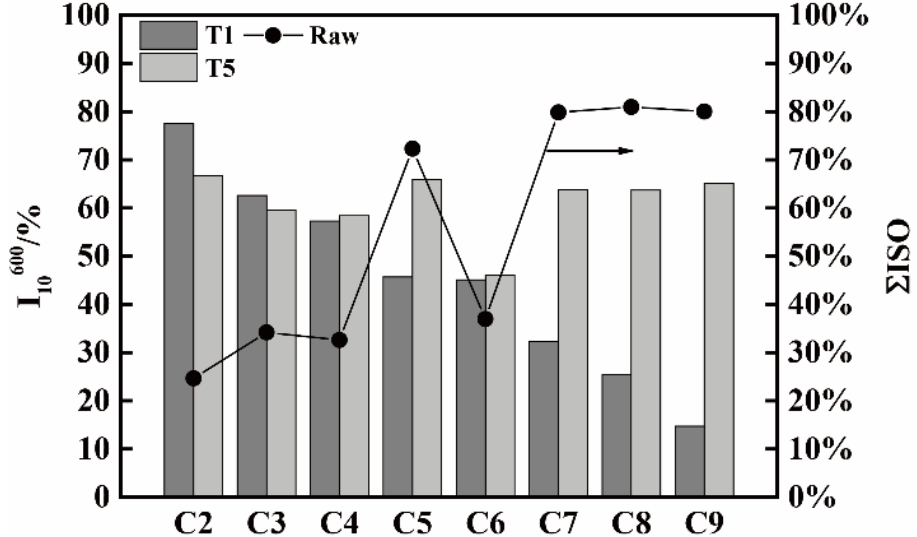
Figure 8. The I 10600 (under T1 and T5) and Σ ISO (raw coke) values for all the cokes.